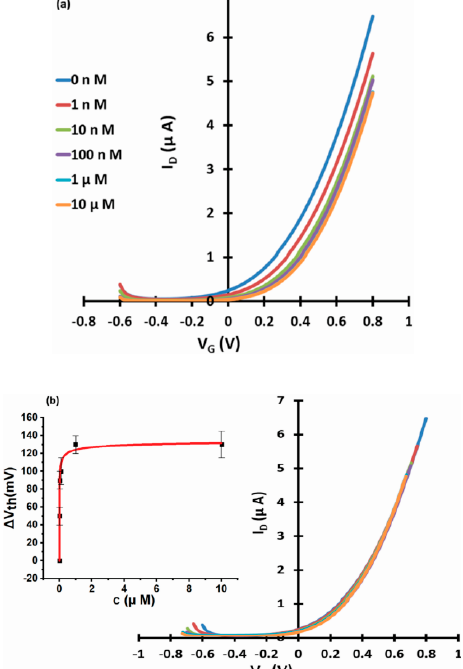
Figure 5. WGTFT fluoride (from NaF) response with Al resin membrane. ( a ) Transfer characteristics of Al-loaded chelating resin-sensitised SnO 2 WGTFT gated under increasing F − concentrations from NaF in the outer pool. ( b ) Master transfer characteristic. Inset to 5b: response characteristic with fit to Equation